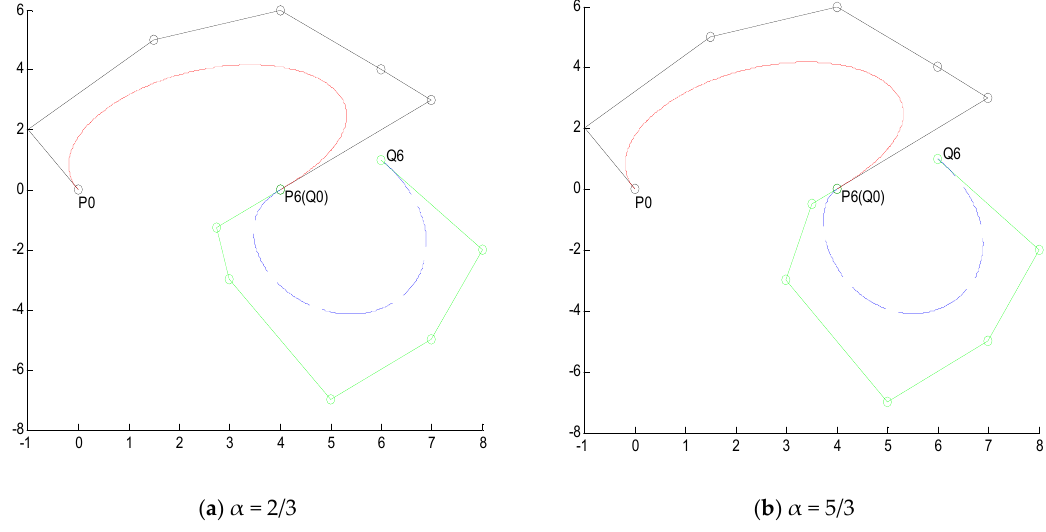
Figure 2. G 1 smooth continuity of two sextic S- λ curves.